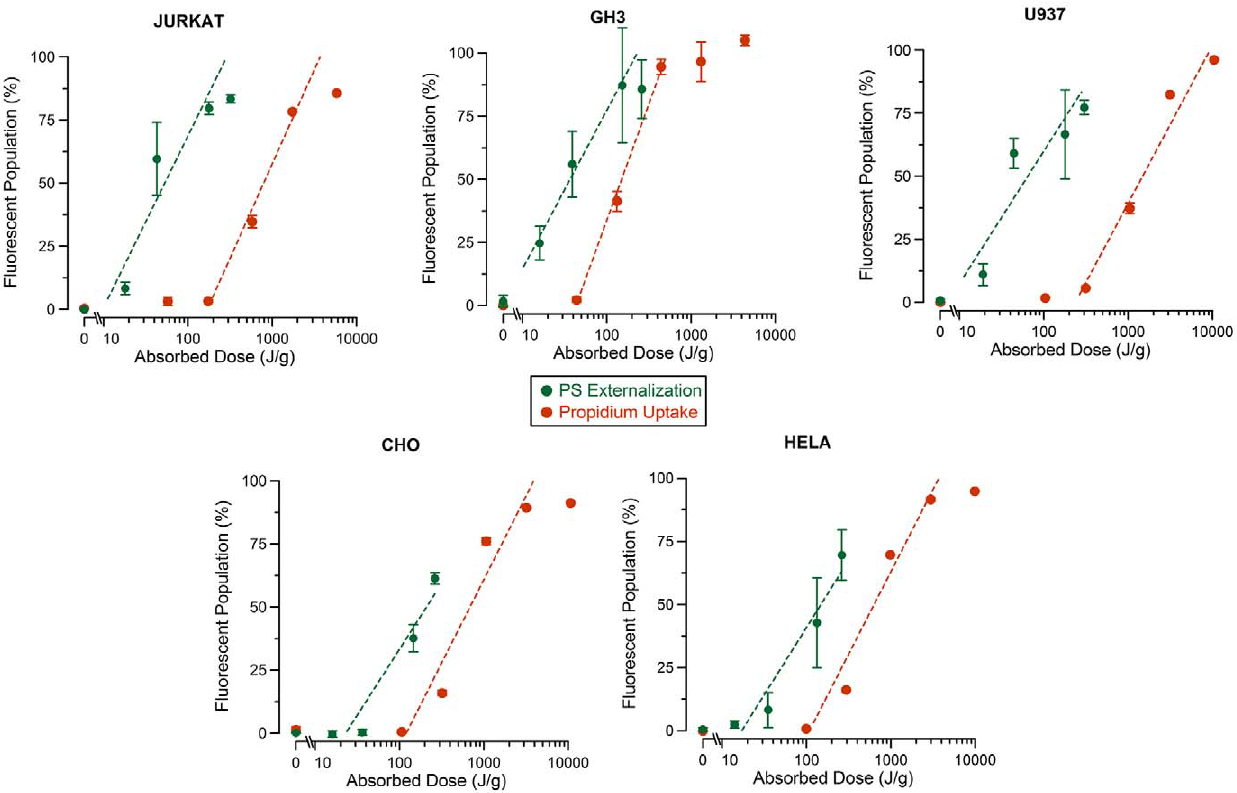
Figure 6. Dose dependence of PS externalization and PI uptake for different cell lines. The percent of the cellular population expressing Annexin V -FITC and Pr was plotted versus absorbed dose for all cell lines tested. Dashed lines represent the logarithmic fit to the data. (mean + / 2 s.d., n=3 measurements of 25,000 cells).